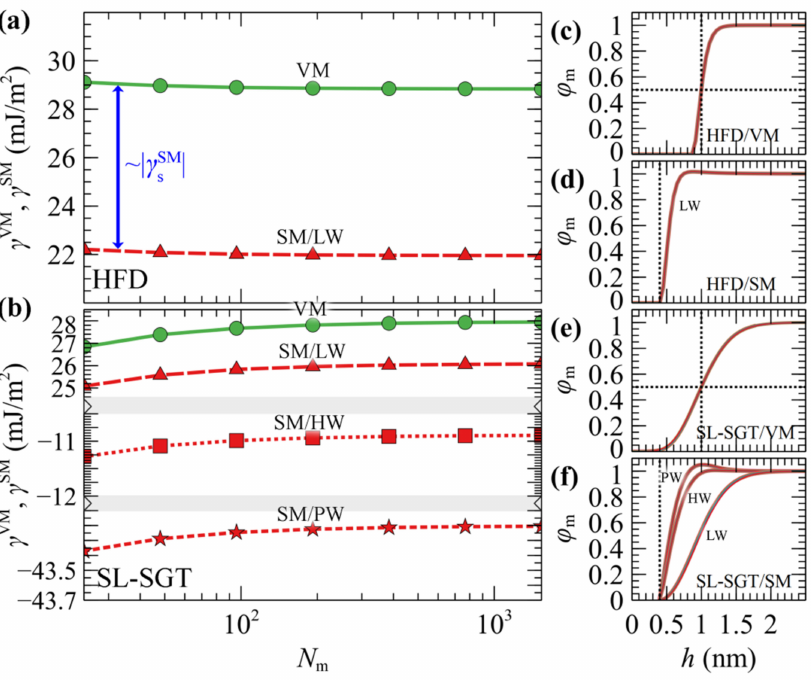
Figure 2. The free energy of vacuum/melt (VM, circles) and bare solid/melt (SM) with low wetting (LW, triangles), high wetting (HW, squares) and perfect wetting (PW, stars) wetting, as a function of chain length using the ( a ) HFD and ( b ) SL-SGT EoS. Bands denote scale changes along the axes. The right panels depict the corresponding reduced density profiles of VM and SM interphases with HFD ( c , d ) and SL-SGT ( e , f ) for N m = 24, 48, 96, 192, 384, 768 and 1536. Even though the thickness of the lines increases with increasing N m , there is practical coincidence of reduced density profiles for all chain lengths; thus, the reader has to zoom considerably to notice any deviations. The dotted lines in ( c – f ) are guides to the